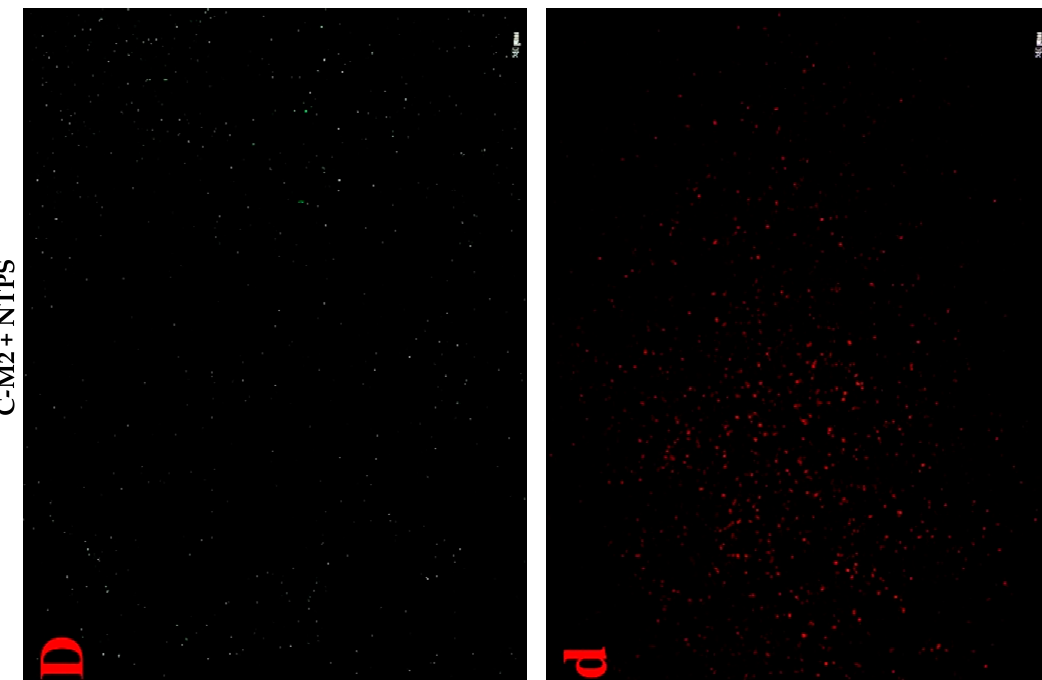
Figure 7. Ratios of SFA/UFA in the cell membrane of Morganella sp. wf-1 with different treatments. ( A , a ) represent untreated control cells; ( B , b ), ( C , c ) and ( D , d ) represent cells treated by C-M2, NTPS and CM2 + NTPS, respectively. The live cells were stained green and dead cells stained red. Scale bars in Figures = 20 μ m.